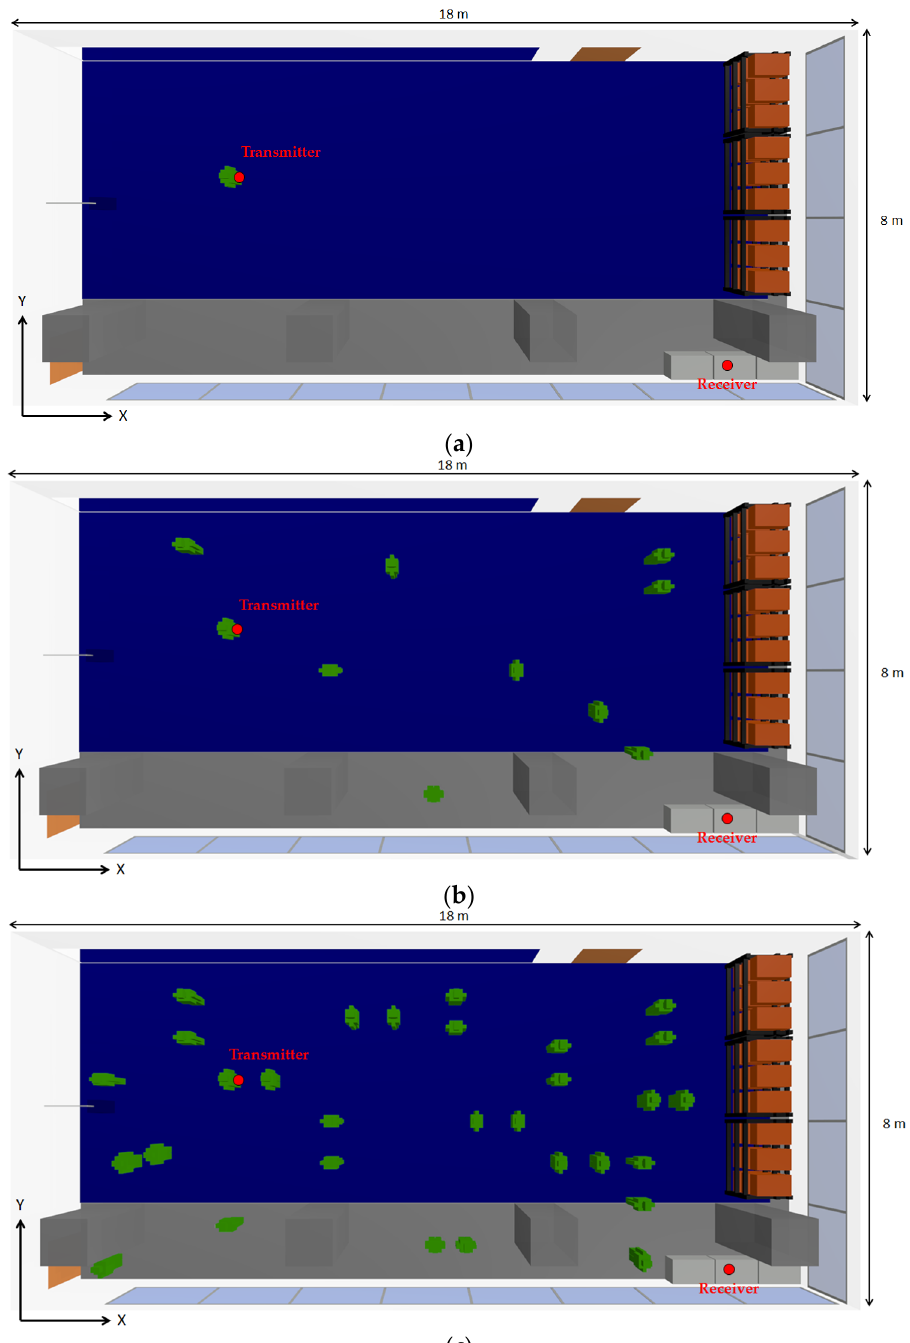
Figure 10. Upper view of the scenario under analysis with the position of the transmitter and the receiver devices (red dots) for the three cases of human being density: ( a ) Without persons; ( b ) With 10 persons; ( c ) With 30 persons.